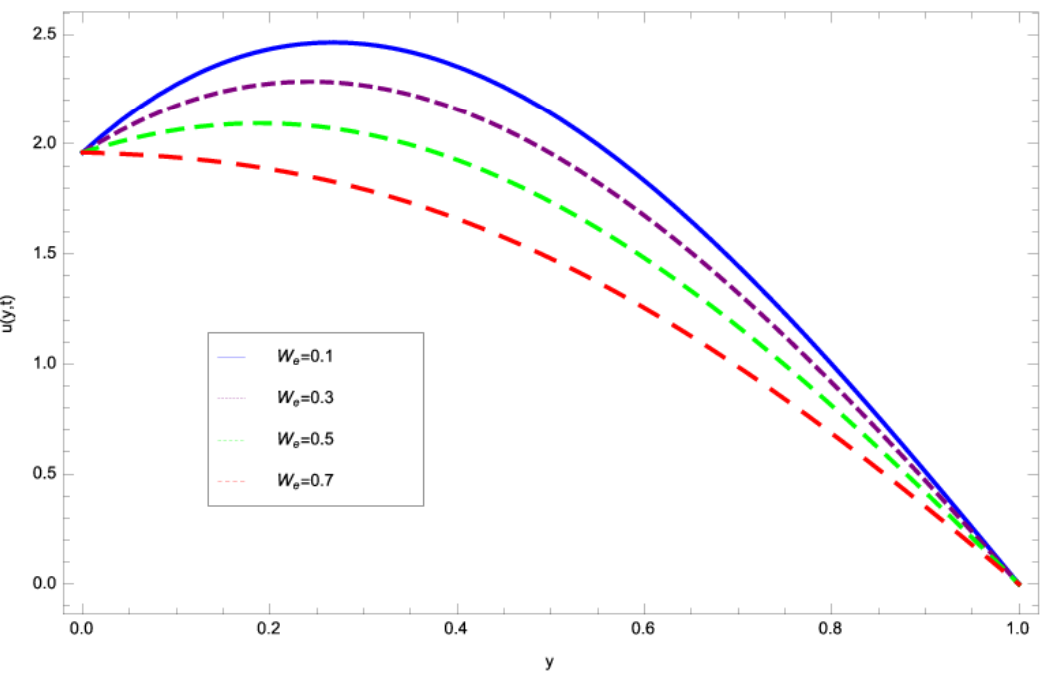
Figure 8. The effect of the Williamson number during fluid motion, when ω = 0.3; m = 0.5; M = 5; t =